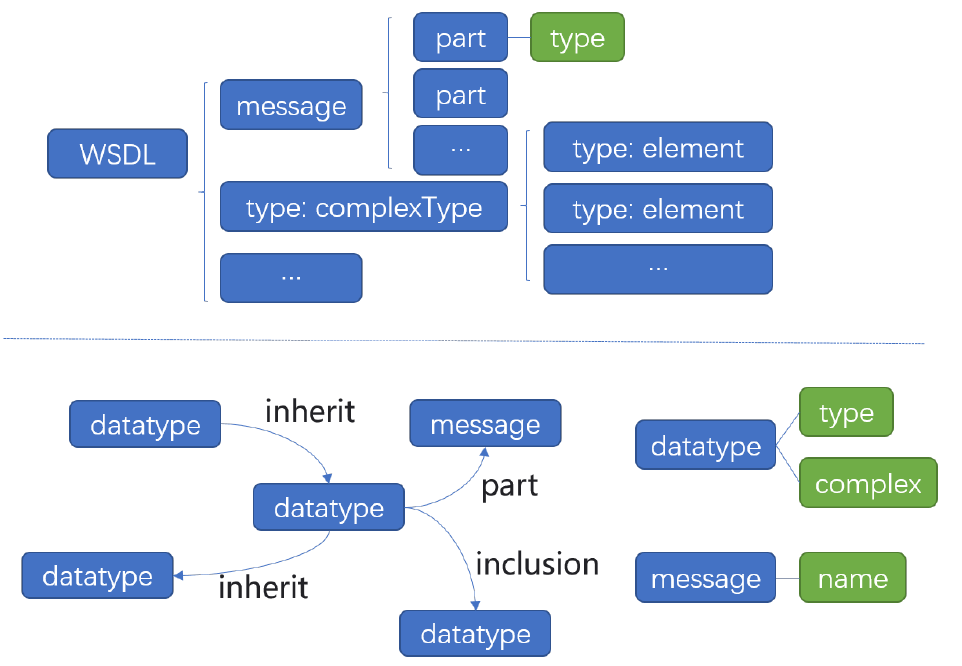
Figure 1. The message and type elements expressed in Web Services Description Language (WSDL) are located at the top. The corresponding message, datatype and relationship defined between them in service knowledge graph are located below. The green box indicates that the content is an attribute, and the blue indicates element (in WSDL) or ontology (in service knowledge graph).